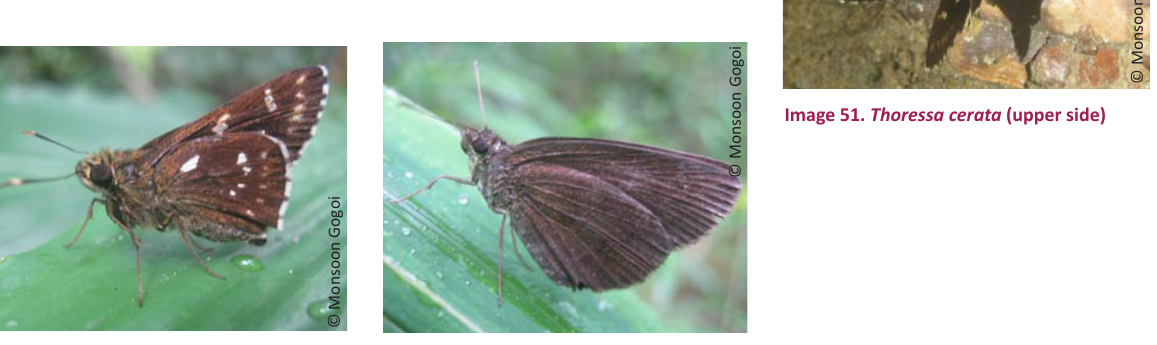
Image 52. Thoressa cerata Image 53. Asticopterus